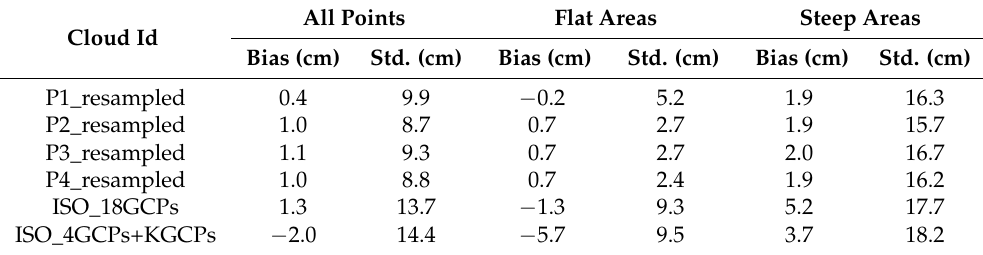
Table 2. Comparison of the reference surface with (row 1 to row 4) randomly-resampled MLS point clouds, (row 5 and row 6) UAS point clouds obtained with different GCP and KGCP